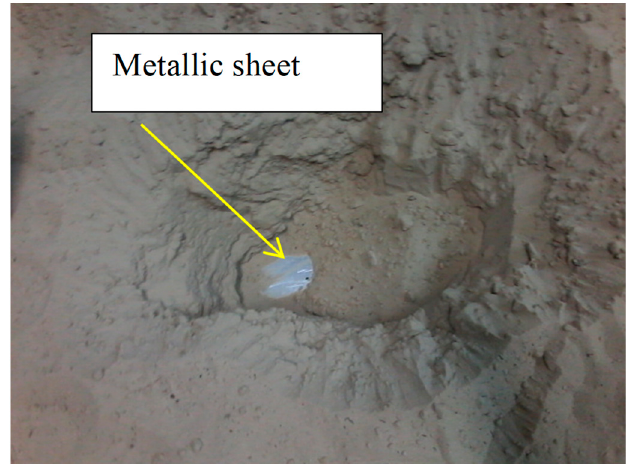
Figure A2. Metallic reflector on the bottom of the sand box.